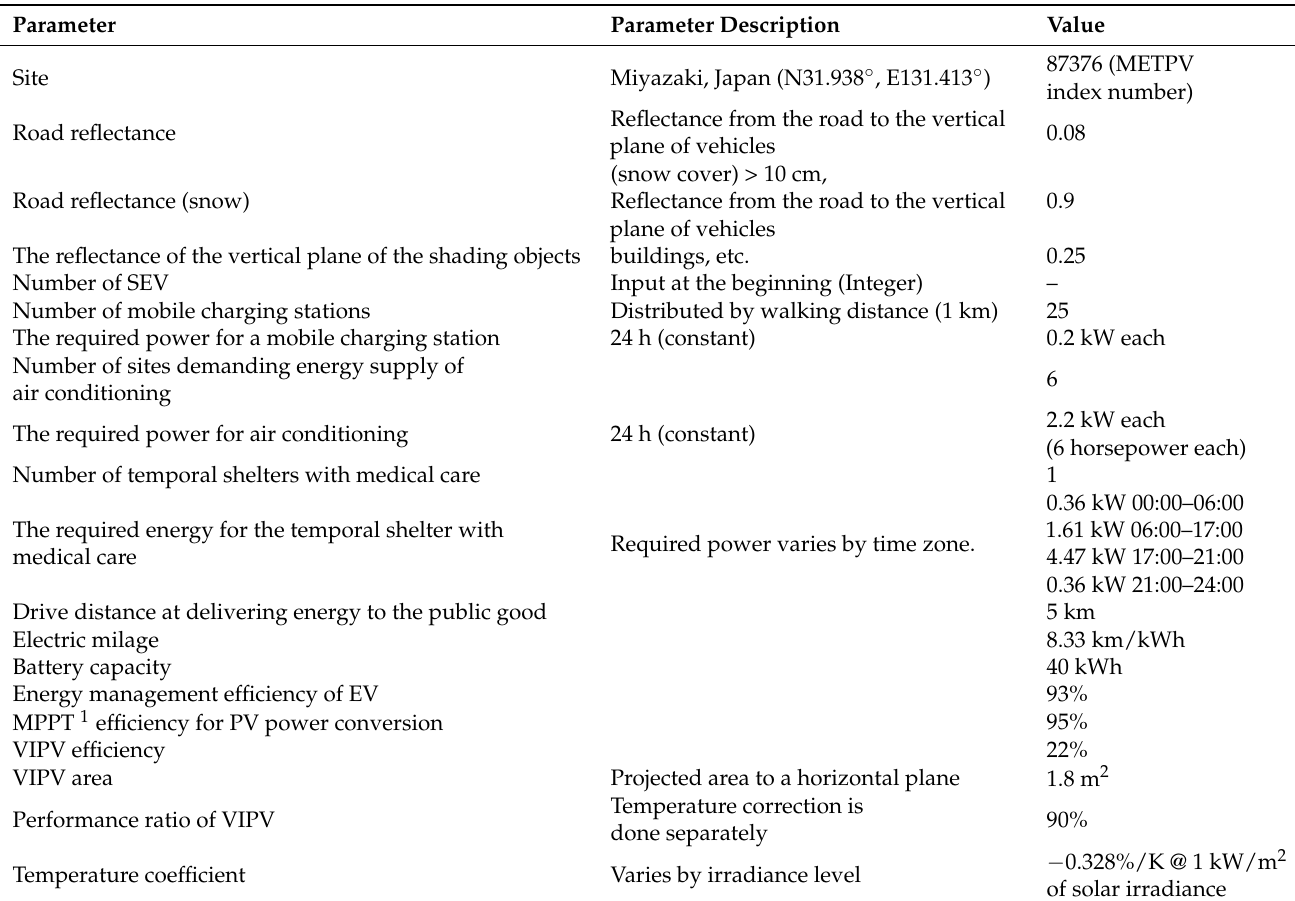
Table 5. List of constant parameters and values used for the Monte Carlo